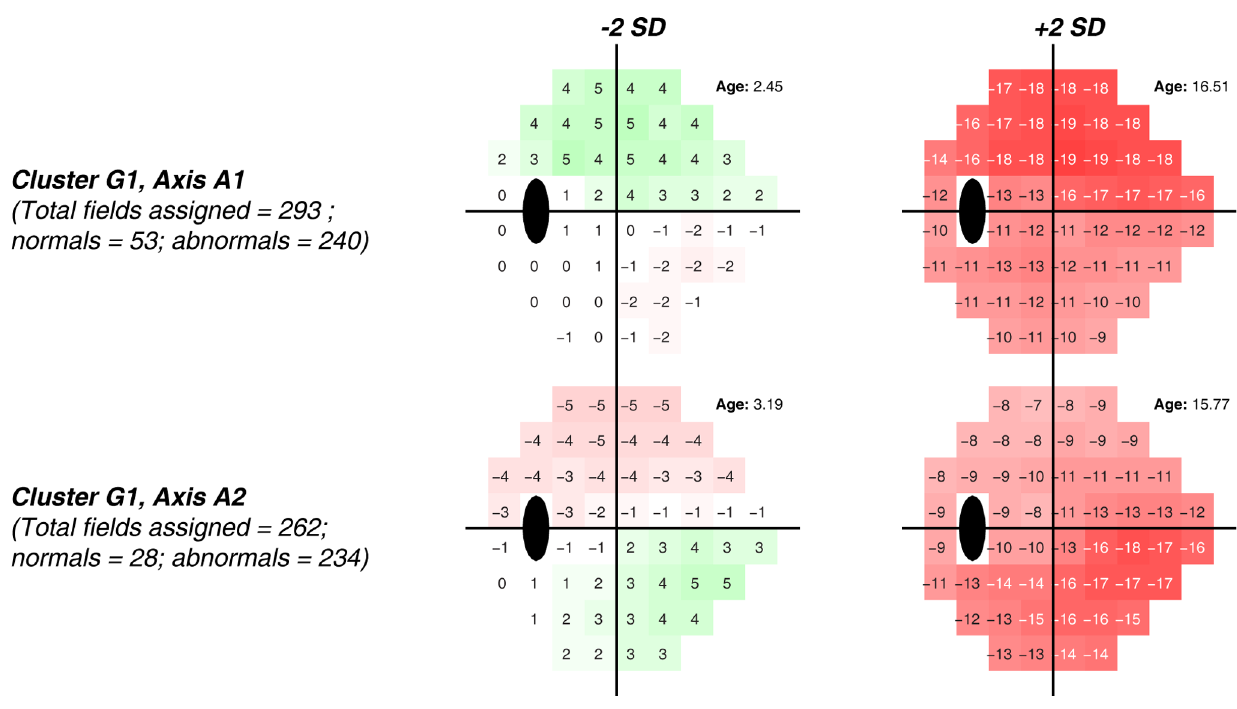
Figure 4. Color-coded displays simulating total deviation plots along with age at 2 2 and + 2 standard deviations of each axis from the centroid of the normal Cluster N , that was composed primarily of abnormal FDT fields. Axis 1 appears to represent primarily moderate superior hemifield defects and Axis 2 appears to represent primarily moderate inferior hemifield defects (i.e., both are altitudinal defects), both showing less severe, diffuse loss in the opposing hemifield.